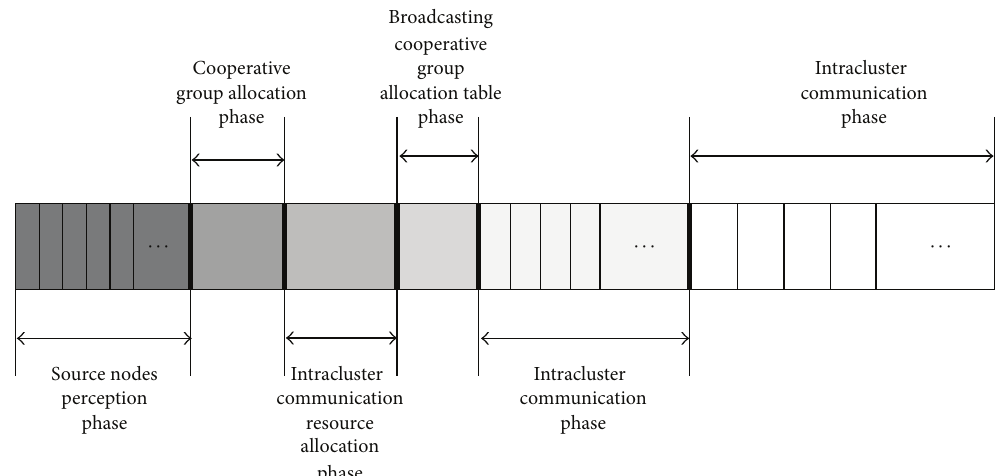
Figure 2: A communication cycle of